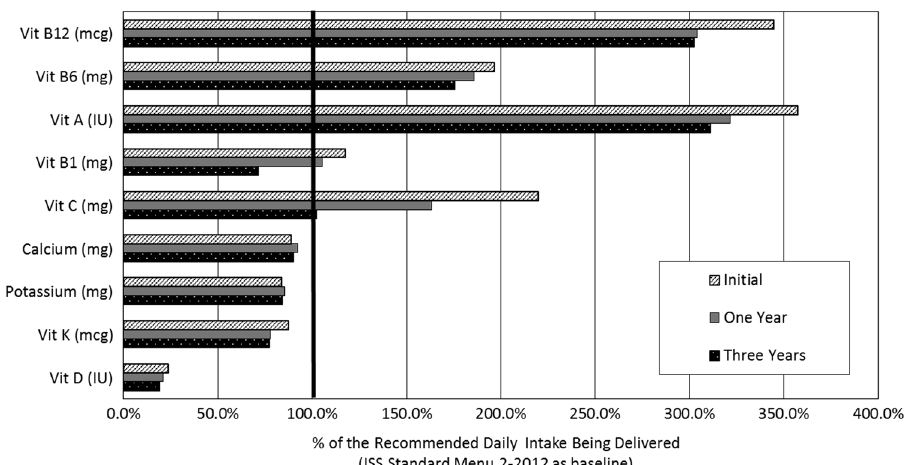
Fig. 1 Expected vitamin delivery for aging space diet consumed according to the ISS Standard Menu. Total concentrations of vitamins D and K as well as calcium and potassium are below recommended intakes post-processing. Vitamin C and B 1 may degrade to inadequate concentrations within 3 years of 21 °C storage; vitamins A, B 6 , and B 12 decline but suf fi cient concentrations remain after 3 years. Beverages were excluded from this analysis because they are not currently part of the standard menu, and are only selected based on crew preference